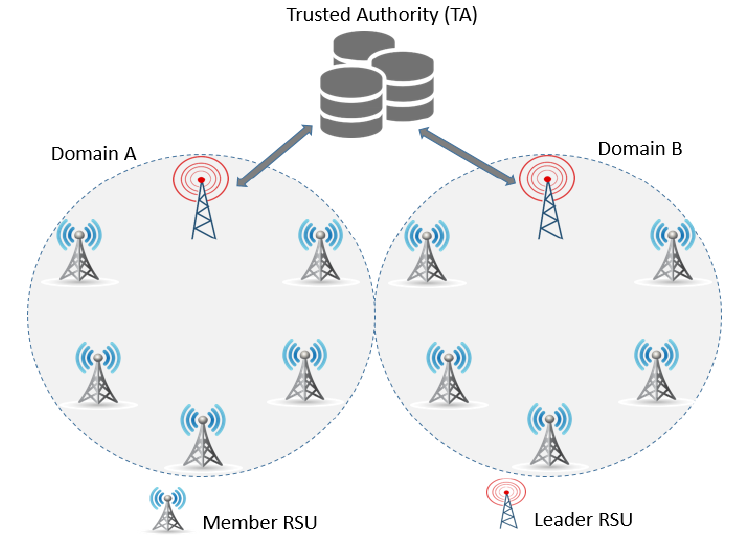
Figure 1. Overview of the system